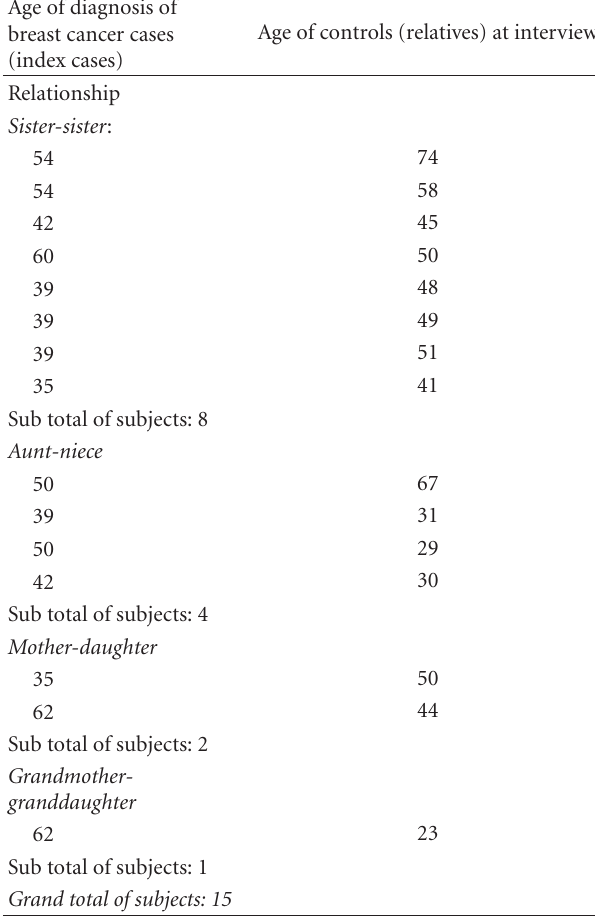
Table 5: Matched cases and controls by relationship: 15